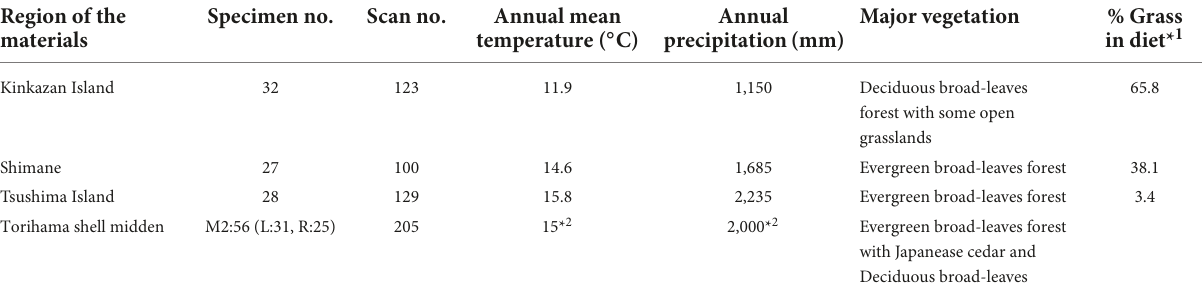
TABLE 1 Habitat environment and food habits related to the materials in this study. Region of the Specimen materials